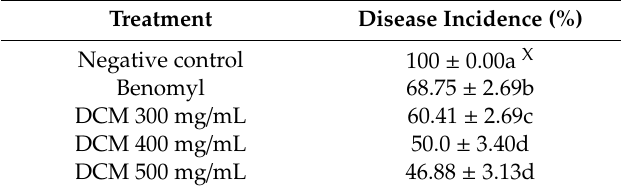
Table 2. Percentage of B. cinerea incidence on tomato treated fruits.